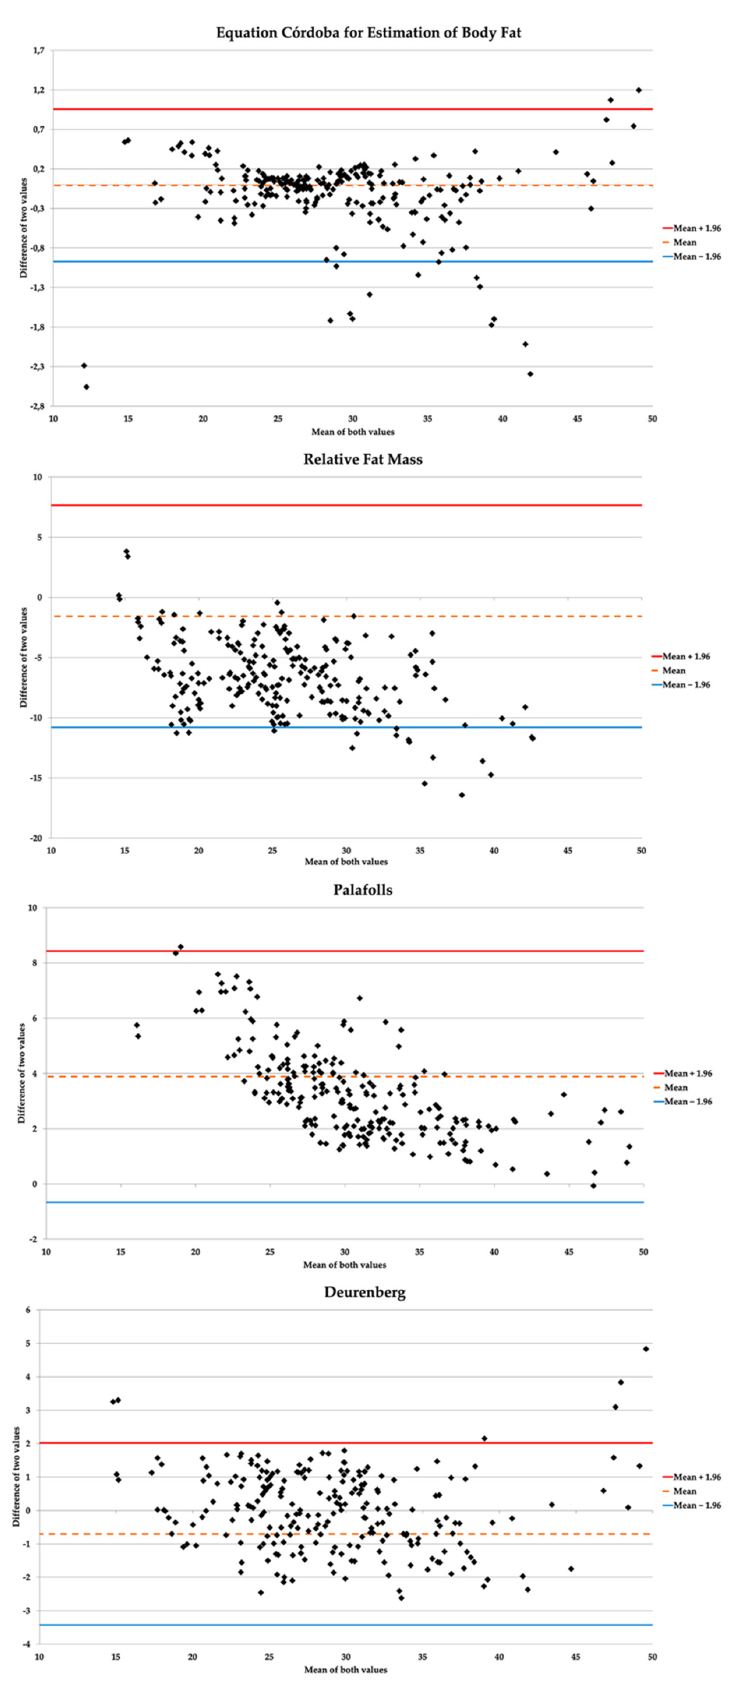
Figure 1. Concordance graphs between study formulas and CUN-BAE ( gold standard) .